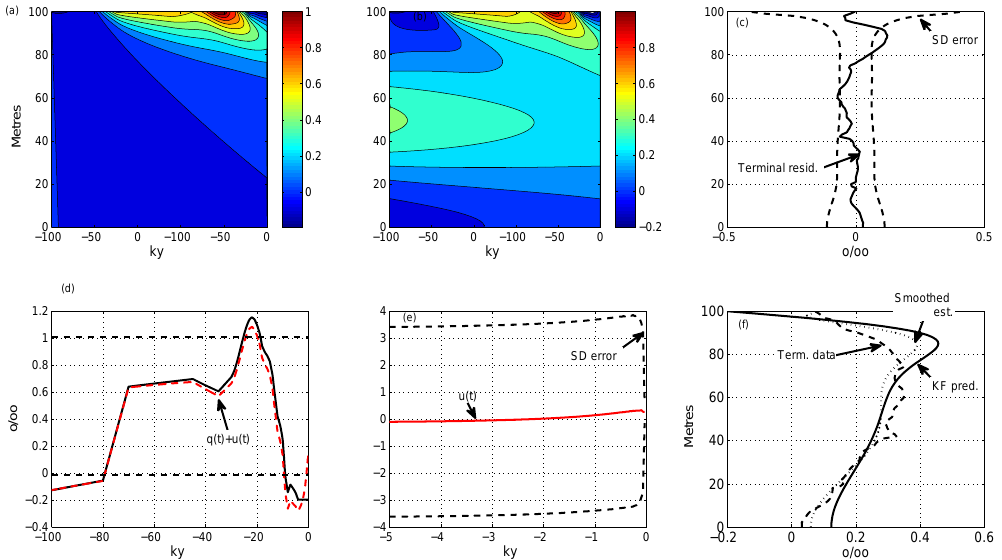
Figure 9. The mean core, upper 100m, and zero initial conditions but with the sea level prior in Fig. 1. The small adjustment, u ( t ) , demonstrates that the terminal data are also consistent with the inference of a very high δ 18 O w at about − 20ky with an increment exceeding 1‰ between the LGM and the present. Note, however, the very large uncertainties remaining in e u ( t )